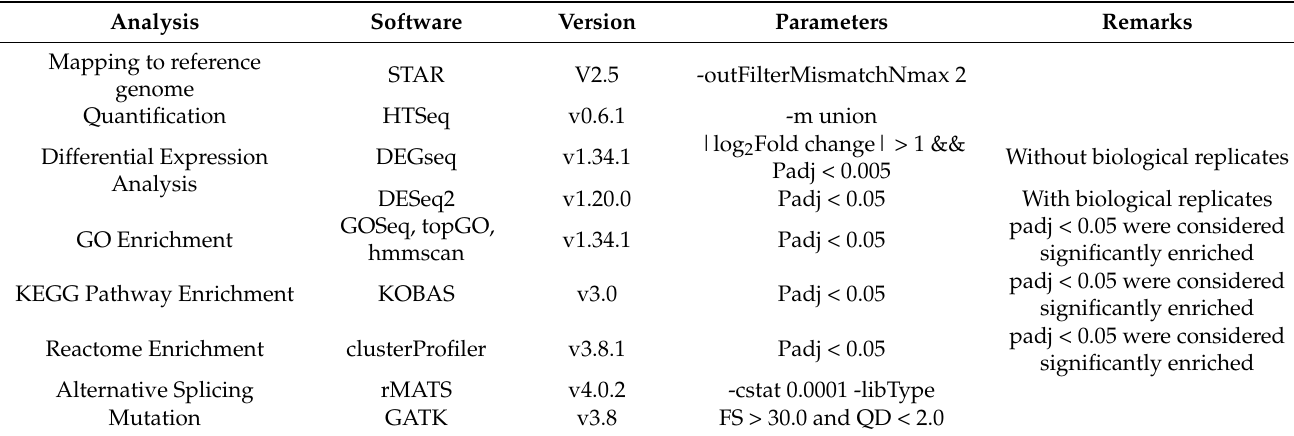
Table 4. mRNA-Sequencing Software.